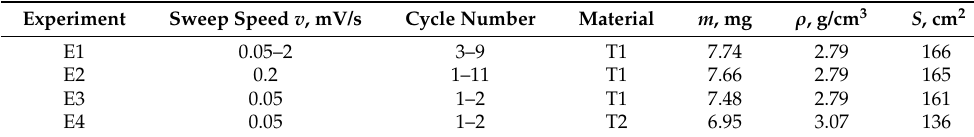
Table 3. Conditions of experiments and parameters of anodes in the CVA measurement.